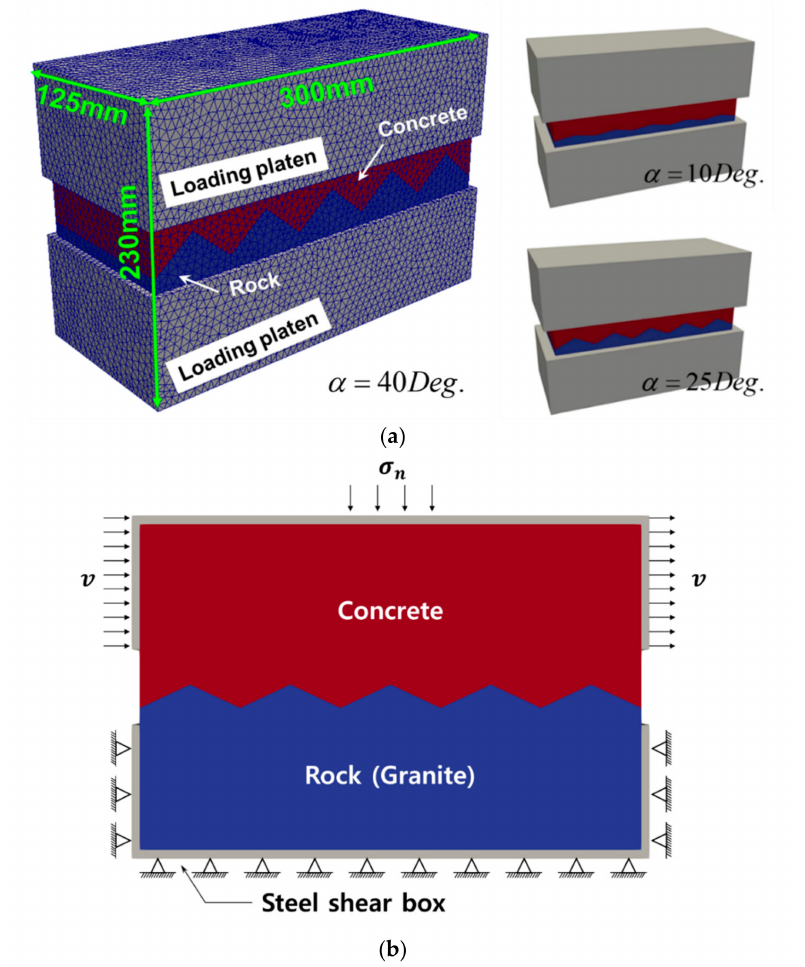
Figure 9. ( a ) A 3D FDEM model for simulating a direct shear test of the specimen with a rough concrete–rock joint with asperity angles α = 10, 25, and 40 degrees, ( b ) cross-sectional view of example of direct shear simulation geometry and boundary conditions for the concrete–rock joint specimen with the asperity roughness (this case is 25 Deg.